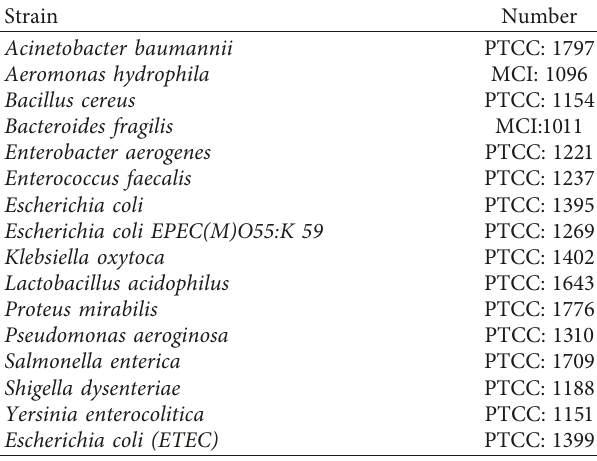
Table 1: Bacterial strains used to evaluate the specificity of α -OmpW ELISA.